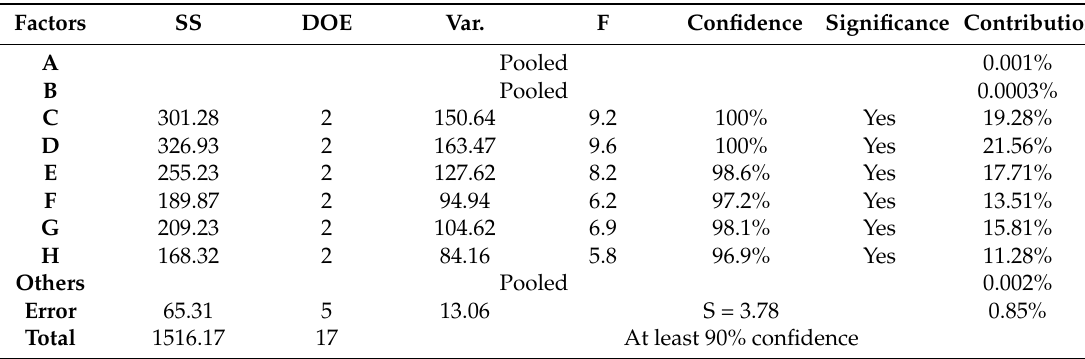
Table 6. SN error